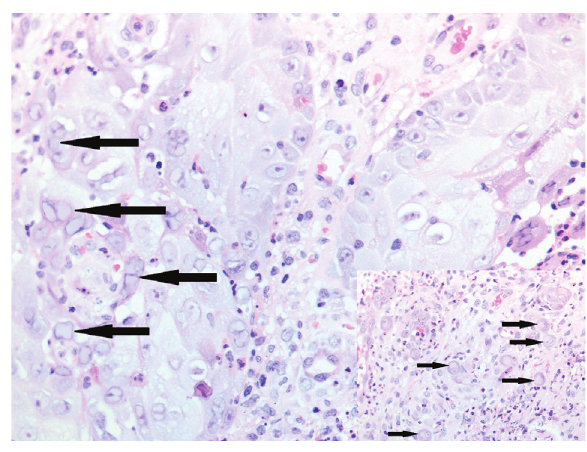
FIGURE 6: Perianal biopsy showing herpes simplex virus and Cytomegalovirus inclusions (inset) in the same biopsy (both original magnification ×